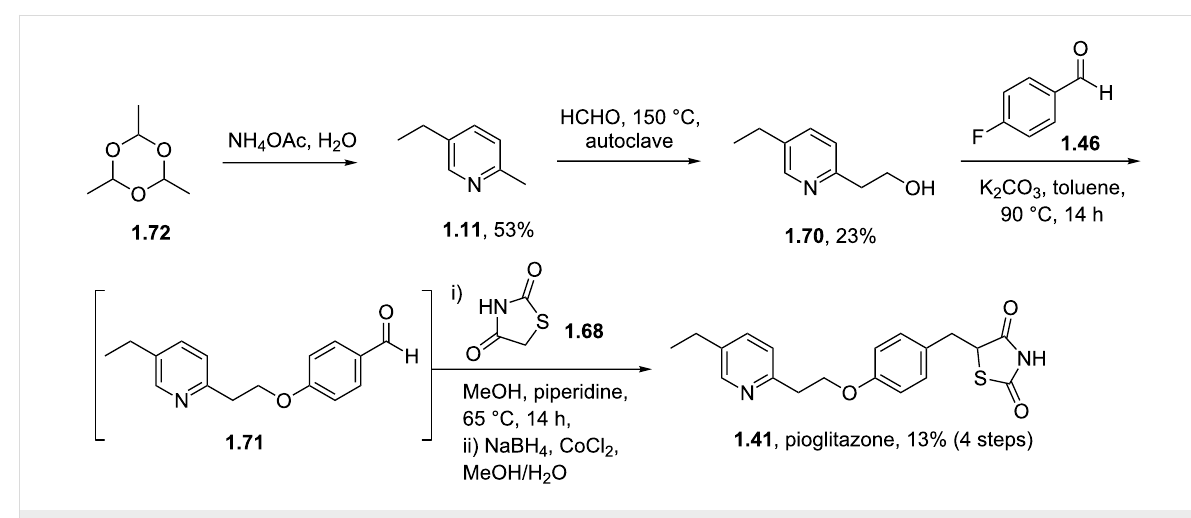
Scheme 12: Synthesis of